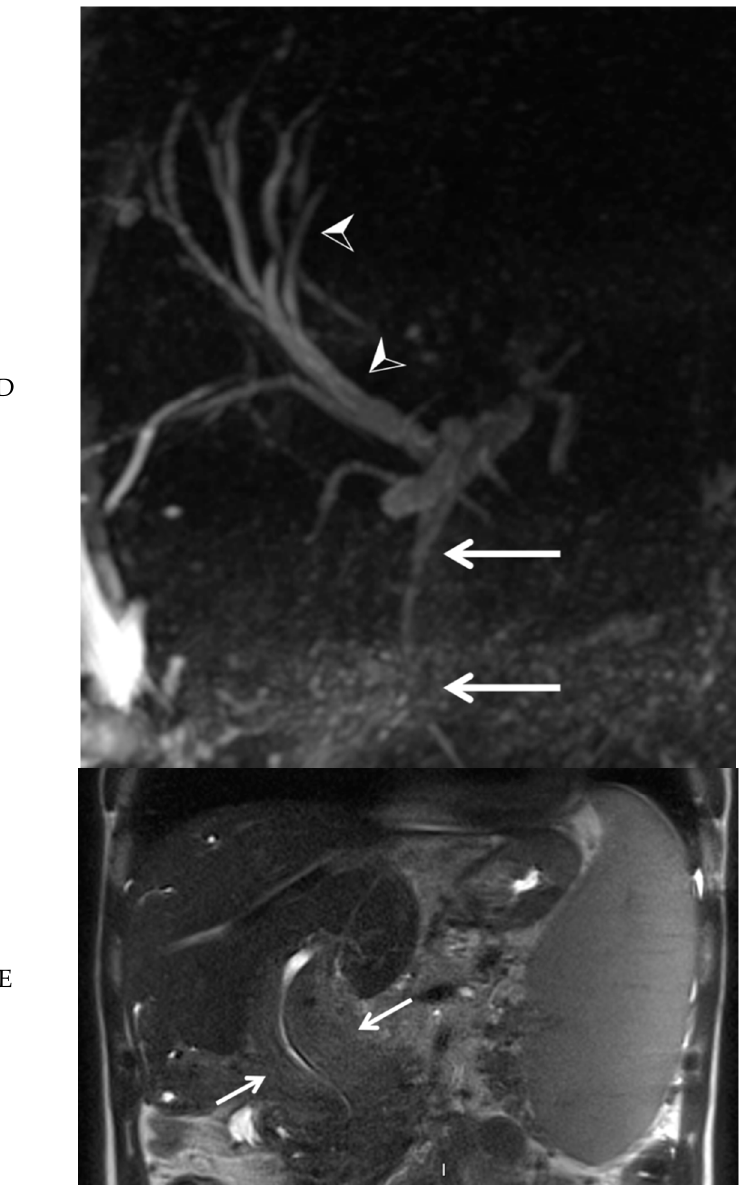
Figure 3. Magnetic resonance imaging of the mass in the upper abdomen (arrows). Shown are T1 weighted subtraction images of the mass in the upper abdomen with fat suppression after administration of intravenous contrast medium in the arterial ( A ), portal venous ( B ), and delayed phase ( C ). At magnetic resonance cholangiopancreaticography, narrowing of the common bile duct is visible along its complete course (arrows), combined with dilation of the intrahepatic bile ducts (arrowheads) ( D ). At T2-weighted imaging ( E , coronal view), the mass surrounding the narrowed common bile duct was slightly hyperintense, when compared to the liver parenchyma (arrows).